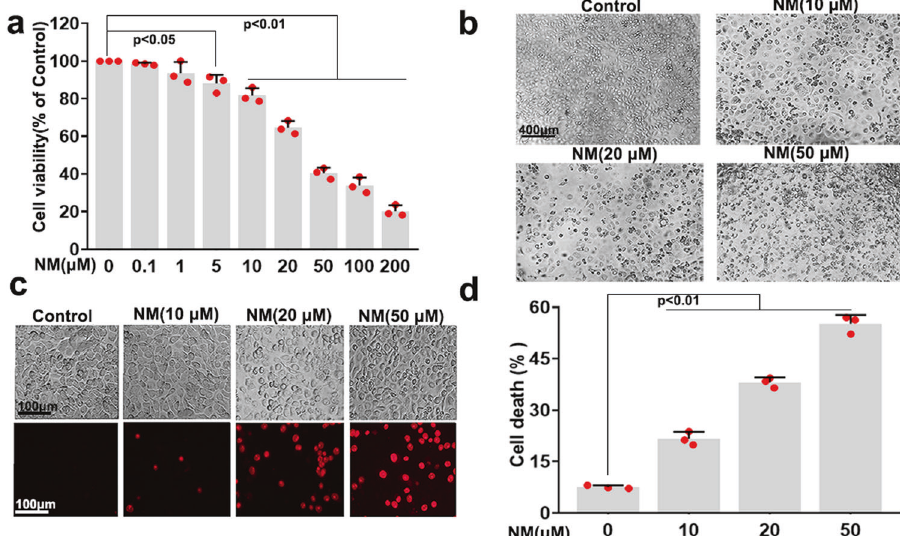
Fig. 1 NM-induced keratinocyte cell death. a Cells were treated with different concentrations of NM (0.1, 1, 5, 10, 20, 50, 100, and 200 μ M) for 24 h. Subsequently, cell viability was measured using a CCK-8 detection kit. b Cells were treated with NM (10, 20, and 50 μ M) for 24 h, and the morphology of cells was detected by microscopy. Cells were treated with NM (10, 20, and 50 μ M) for 24 h, and cell death was determined with PI staining followed by c fl uorescence microscopy or d fl ow cytometry. Values are presented as means ± SD ( n =